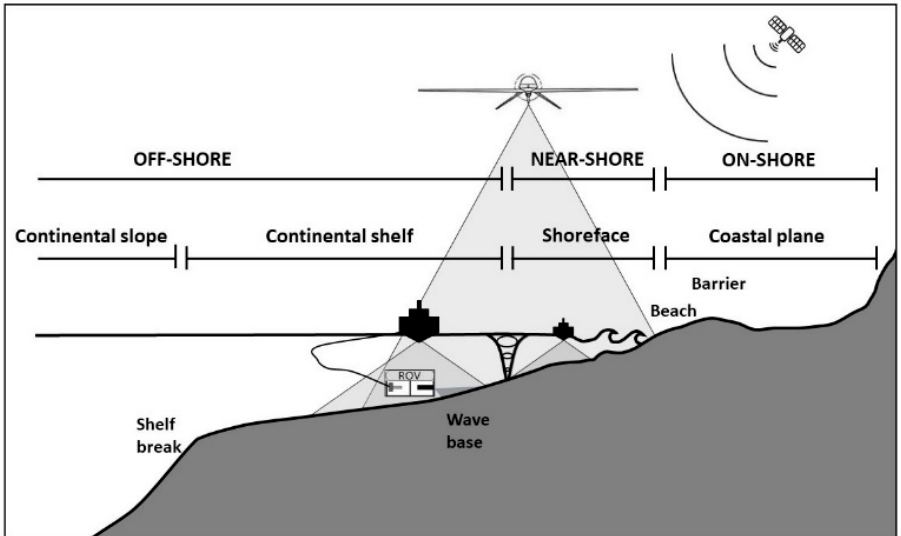
Figure 1. Different technological solutions for collecting high-resolution terrestrial and marine data exploiting different platforms: satellite imagery, airborne Light Detecting And Ranging (LiDAR) and bathymetric LiDAR, Uncrewed Aerial Vehicles (UAV)-mounted instruments, and keel-mounted and ROV (Remotely Operated Vehicle)-mounted echo-sounders to obtain high-resolution imagery and derived datasets such as DEMs and DTMs. Note the comparison of different coverages between traditional bathymetric survey vessels (equipped with acoustic systems, such as MBES-MultiBeam EchoSounders) and airborne optical sensors (i.e., bathymetric LiDAR), both in deep and shallow water. The advantages in time and costs of using the latter is obvious, although LiDAR systems provide a lower spatial sampling rate that generates much lower accuracy and precision than that offered by acoustic systems, especially when approaching extinction depths (see Section 3.2 and Table 1 for further details on pros and cons ).